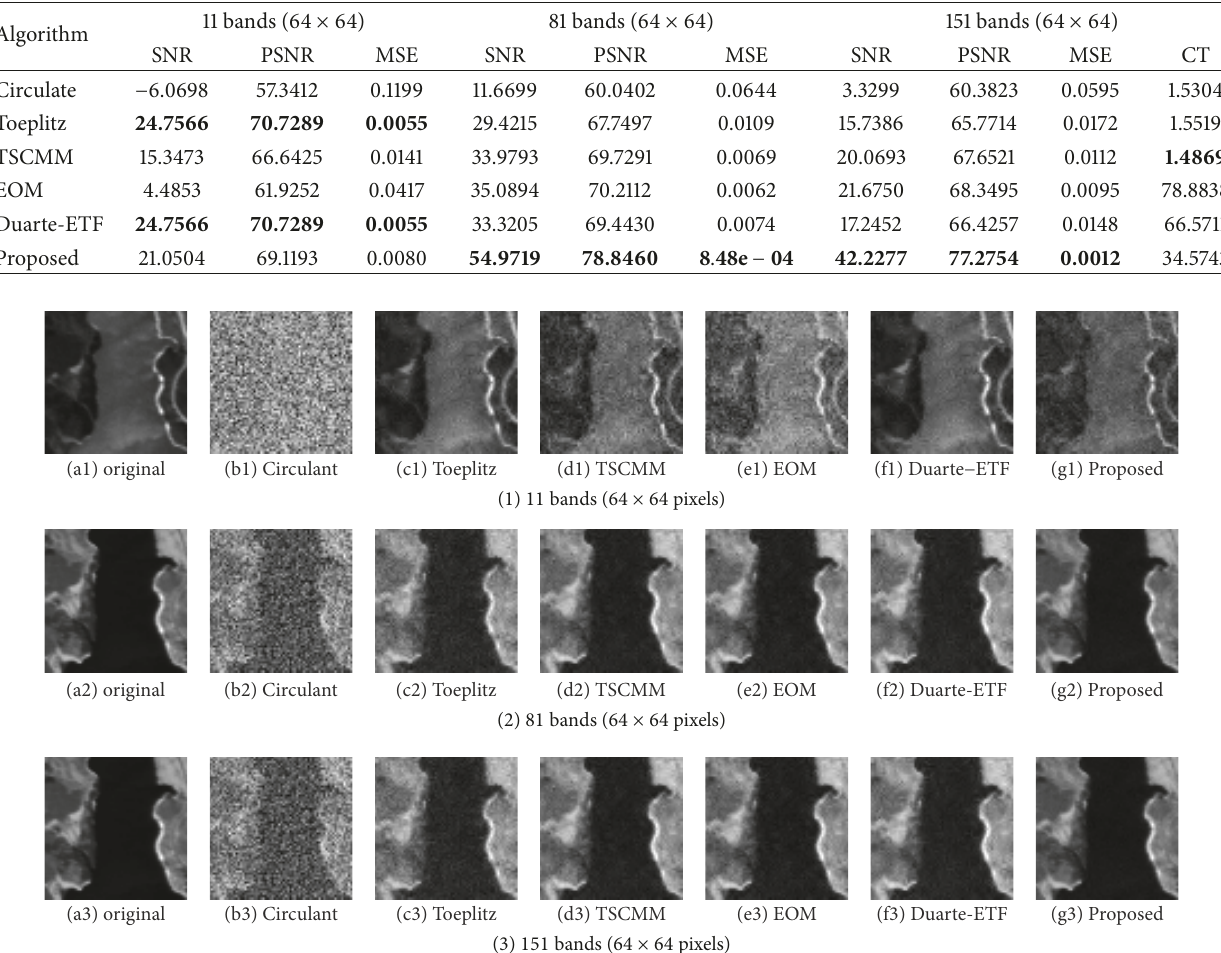
Figure 7: The subjective quality of different CS measurement matrices, from left to right: (a) original, (b) Circulant, (c) Toeplitz, (d) TSCMM, (e) EOM, (f) Duarte-ETF, and (g) proposed